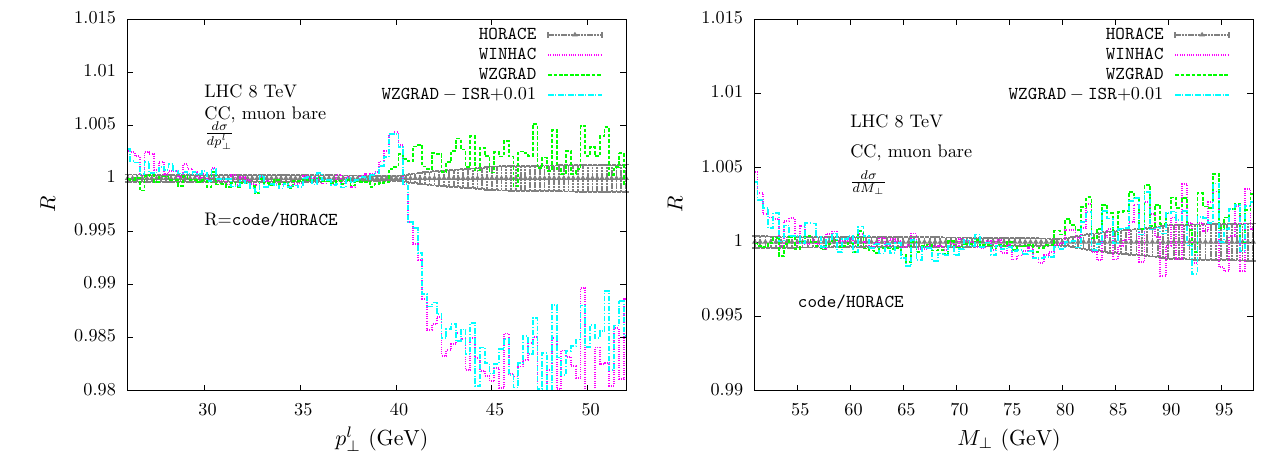
Fig. 31 Tuned comparison of the lepton transverse momentum ( left ) andlepton-pairtransversemass( right )distributionsin pp → μ + ν μ + X for the 8 TeV LHC with ATLAS/CMS cuts in the tuned compari-